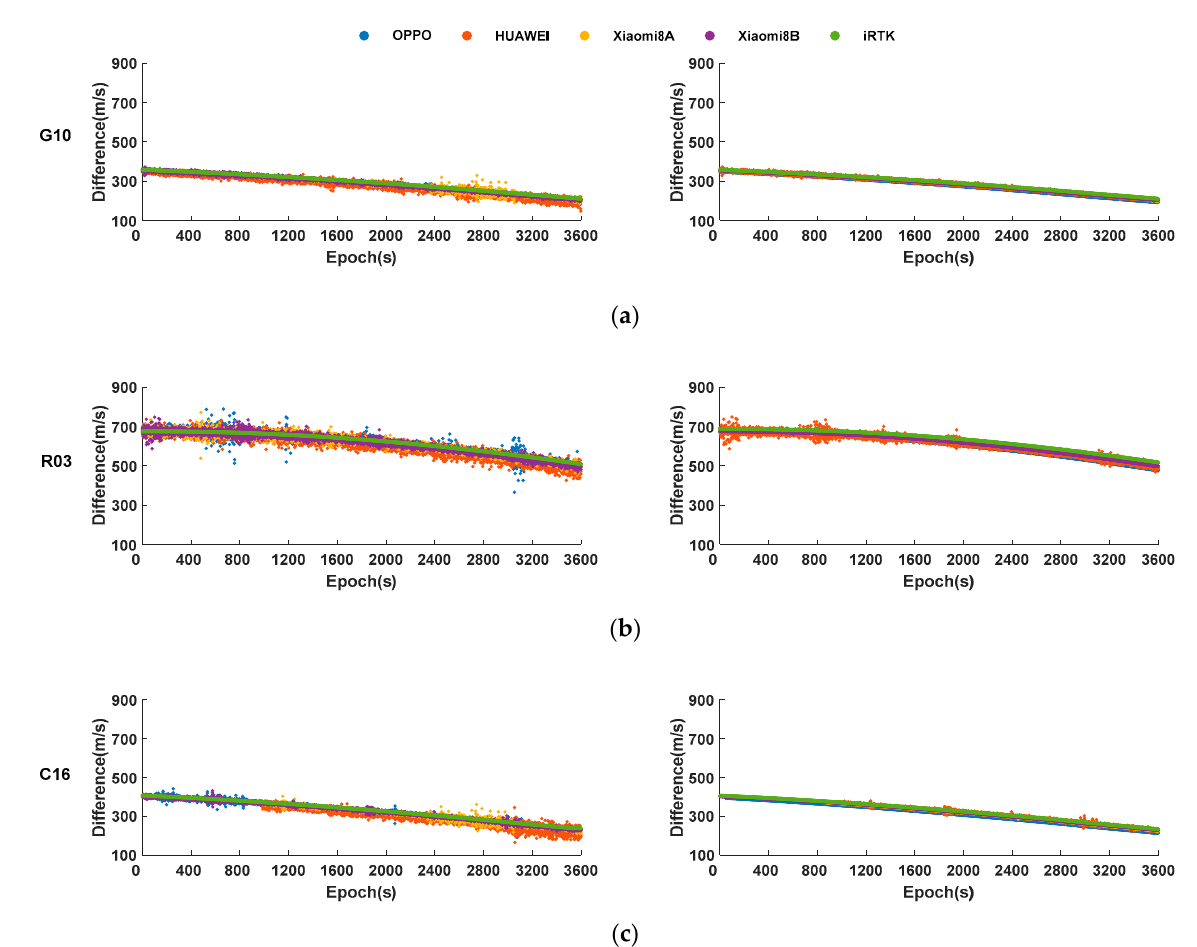
Figure 4. The rate of change of pseudorange and carrier obtained by smartphones and iRTK2 after processing. ( a ) The rate of change of pseudorange and carrier of G10. ( b ) The rate of change of pseudorange and carrier of R03. ( c ) The rate of change of pseudorange and carrier of C16. Table 2. The RMSE of combinative observation of each smartphone (Based on the results of iRTK2). OPPO HUAWEI Xiaomi 8 A Xiaomi 8 B Pseudorange Carrier Pseudorange Carrier Pseudorange Carrier Pseudorange Carrier G